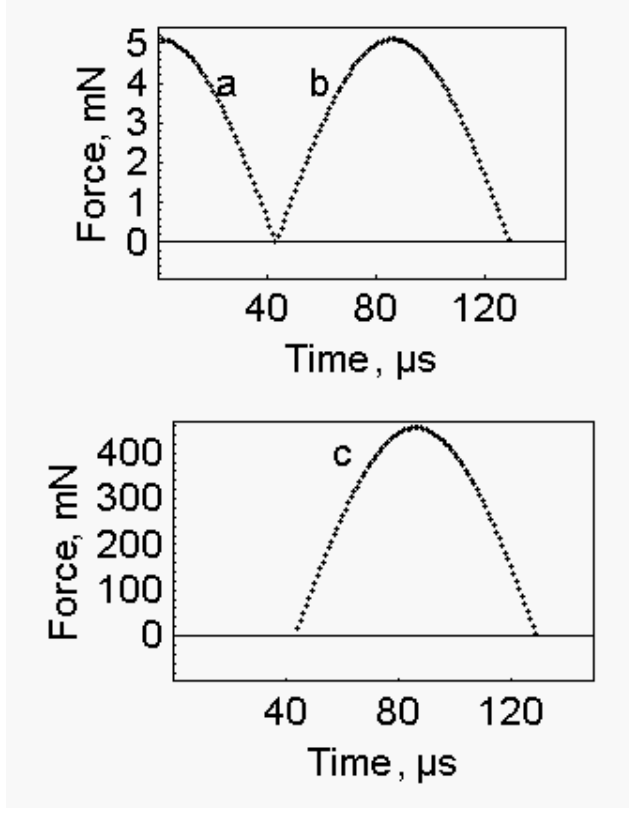
Figure 5. Change of the elastic force during the shortening accompanying the quick release and the subsequent lengthening - The conditions are as described in Figure 4.